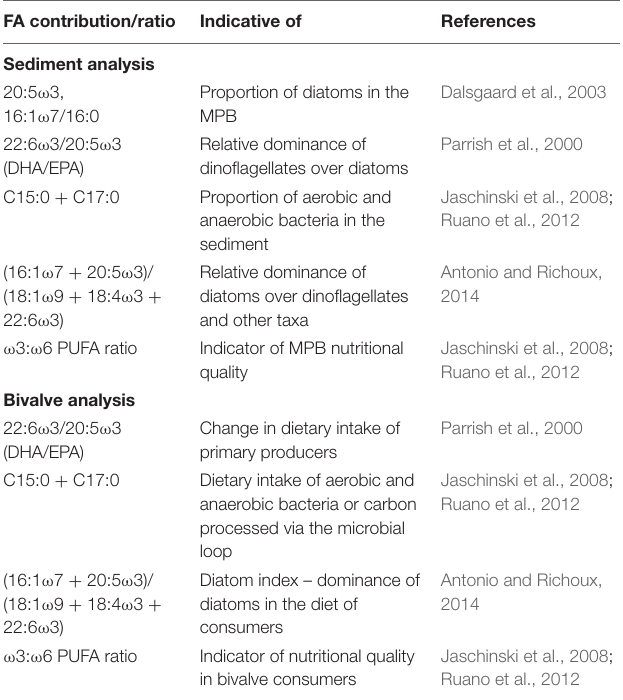
TABLE 1 | Fatty acid (FA) biomarkers and indices used to indicate the presence of various Microphytobenthos (MPB) taxa in surface sediments and bivalve tissue. FA contribution/ratio Indicative